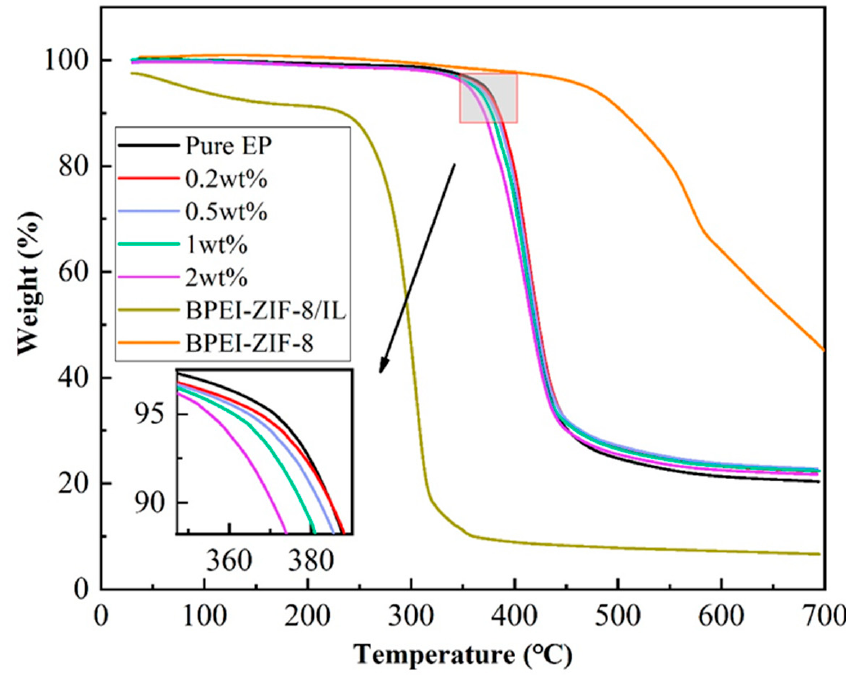
Figure 3. TGA curves of pure EP and BPEI-ZIF-8/IL/EP composites with different contents of BPEI-ZIF-8/IL.